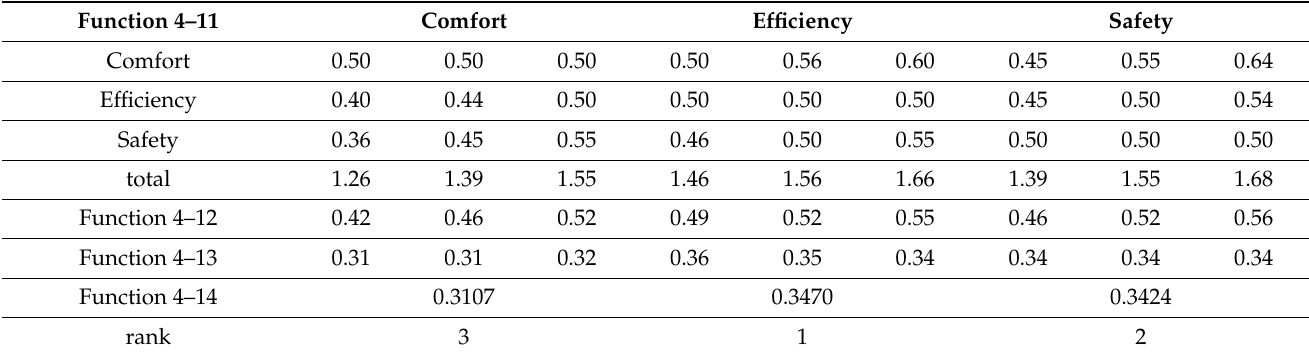
Table A9. Travel agencies’ weights of attributes of the functional value.